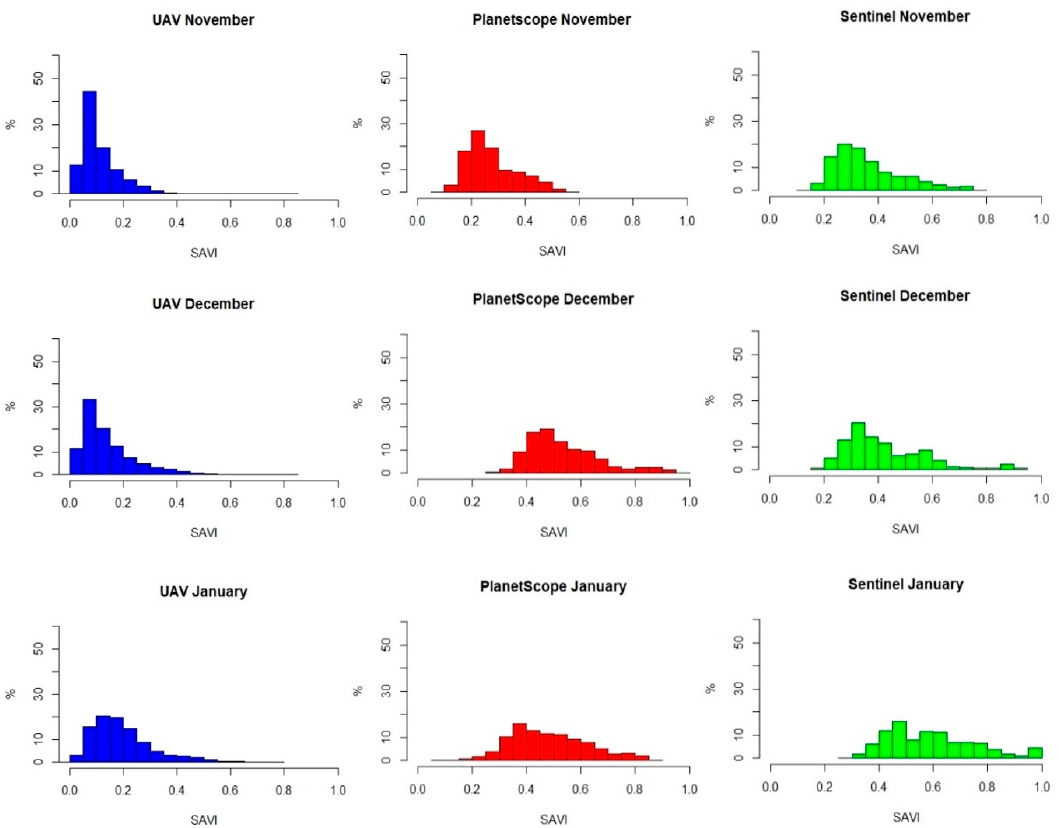
Figure 5. Histograms showing the distribution of SAVI values as a percentage of total values. The imagery of UAV is represented in blue, PlanetScope in red, and Sentinel-2 in green.